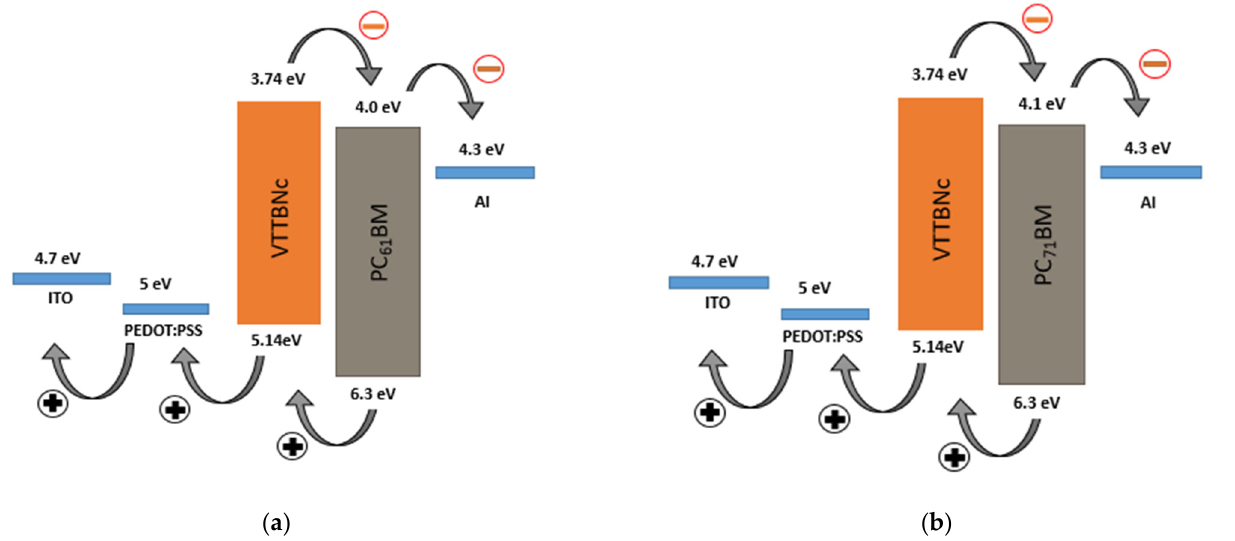
Figure 5. The HOMO-LUMO energy levels and work function for the organic photodiode (OPD) devices ( a ) ITO/PEDOT:PSS/VTTBNc:PC 61 BM/Al ( b ) ITO/PEDOT:PSS/VTTBNc:PC 71 BM/Al.